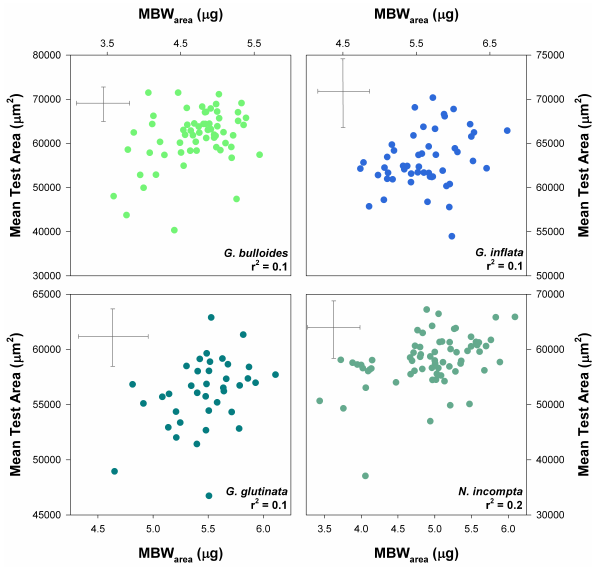
Fig. 2. Measurement-based weight (MBW area ; µg) versus test area (µm 2 ) for each of the species considered as part of this study. No correlations are observed between MBW area and area, suggesting that the measurement-based method isolates the influence of test wall thickness and density from that of size on test weight.